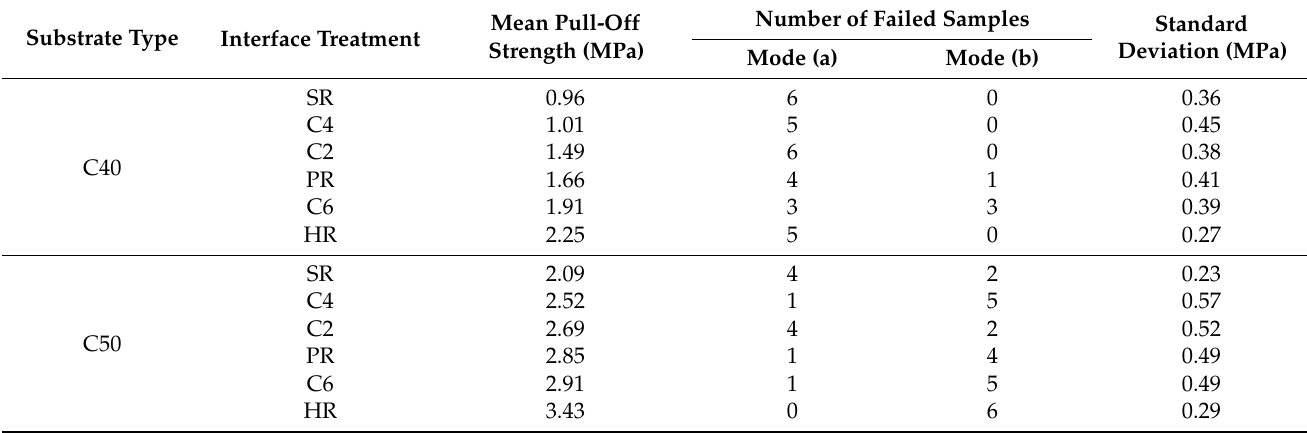
Table 3. Summary of the pull-off test